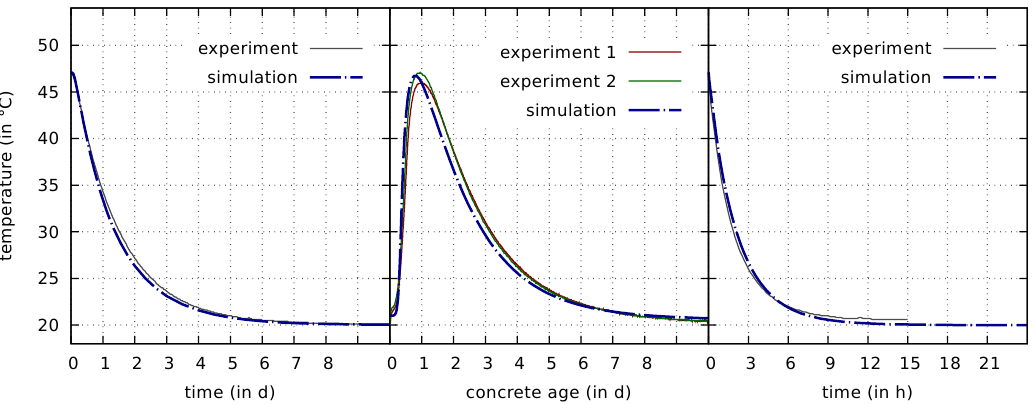
Figure 1. Comparisons of computed and measured temperature evolutions for a matured and preheated insulated cubic specimen ( left ), for a hardening insulated cubic specimen ( center ), and for a matured and preheated cylindrical specimen without insulation ( right